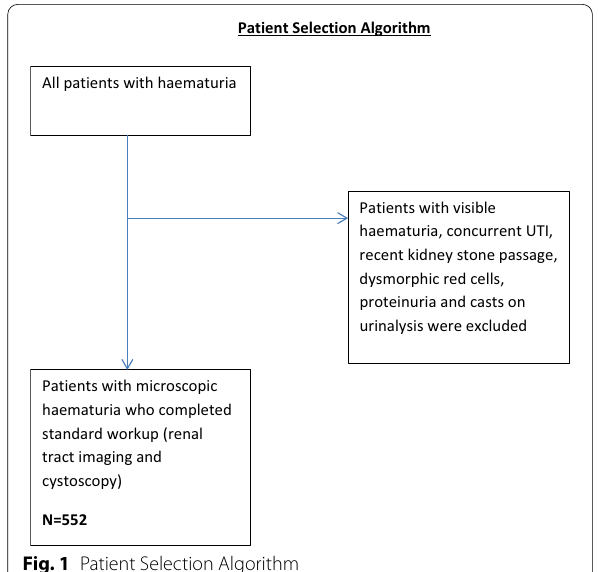
Fig. 1 Patient Selection